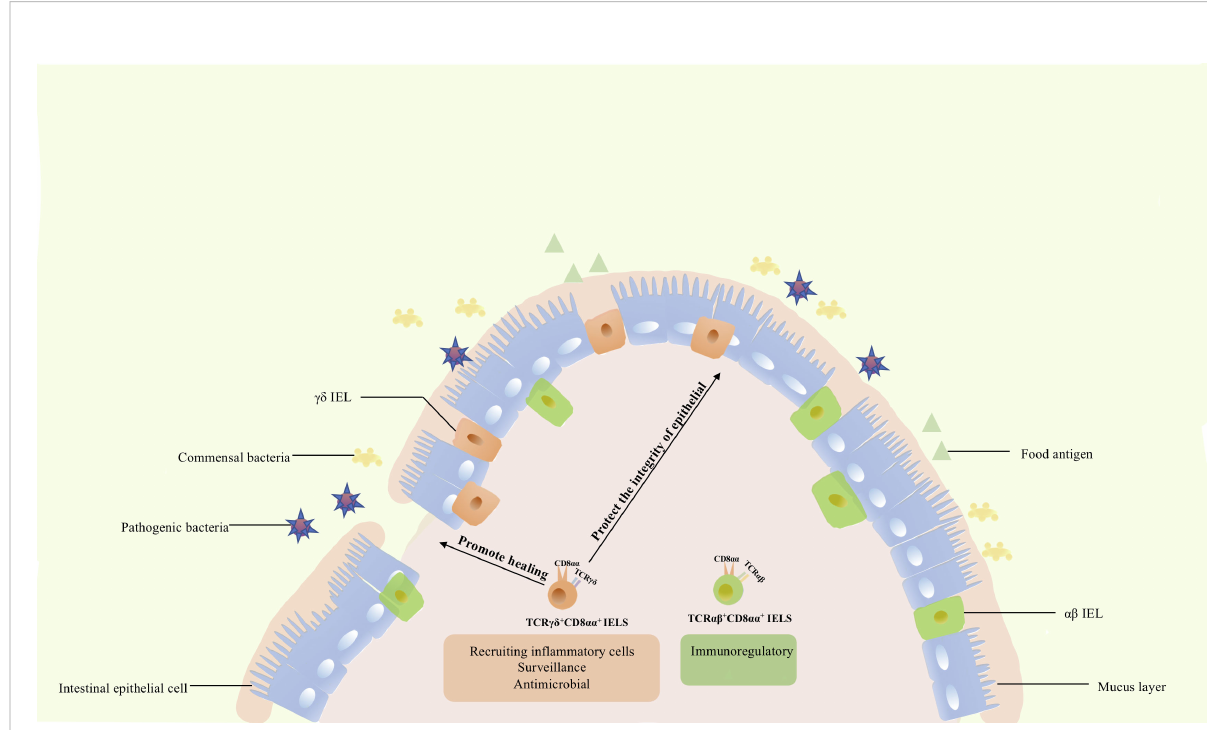
FIGURE 3 The functions of CD8 aa IELs. TCR ab + CD8 aa + IELs express Ly49A, Ly49C, Ly49E, and other genes of the Ly49 family, as well as 2B4, fi brinogen-like protein-2, TGF- b 3, and LAG-3, being involved in immune regulation. In contrast to TCR ab + CD8 aa + IELs, TCR gd + IELs express TGF b 1, TGF b 3, prothymosin b 4, heat shock proteins, chemokine KC, and b ig-h3, being involved in injury healing and protection of the integrity of epithelium. Meanwhile, these cells could also express cytokines KC, IL-1 b , MIP2 a , Cxc19, and Cxc116 thus recruiting various in fl ammatory cells. Besides, they are characterized by a speci fi c dynamic pattern to surveil and respond to pathogen invasion, undertaking diverse roles in the